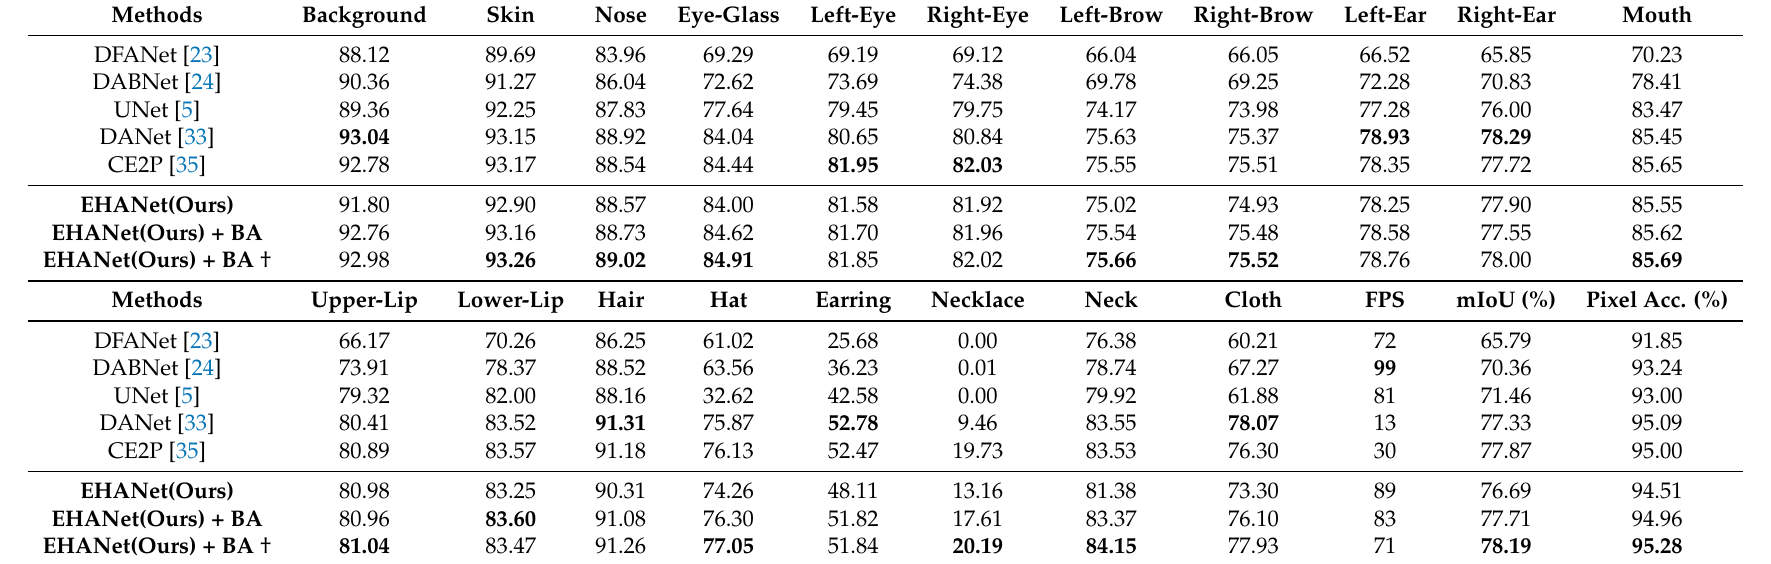
Table 1. Category-wise comparison (IoU) on the CelebAMask-HQ test set. The best performance for each individual class is marked with bold-face number. “BA” denotes boundary-aware branch, “†” denotes EHANet with ResNet34 backbone, “FPS” denotes frames per second. Resolution is unified to 512 ×